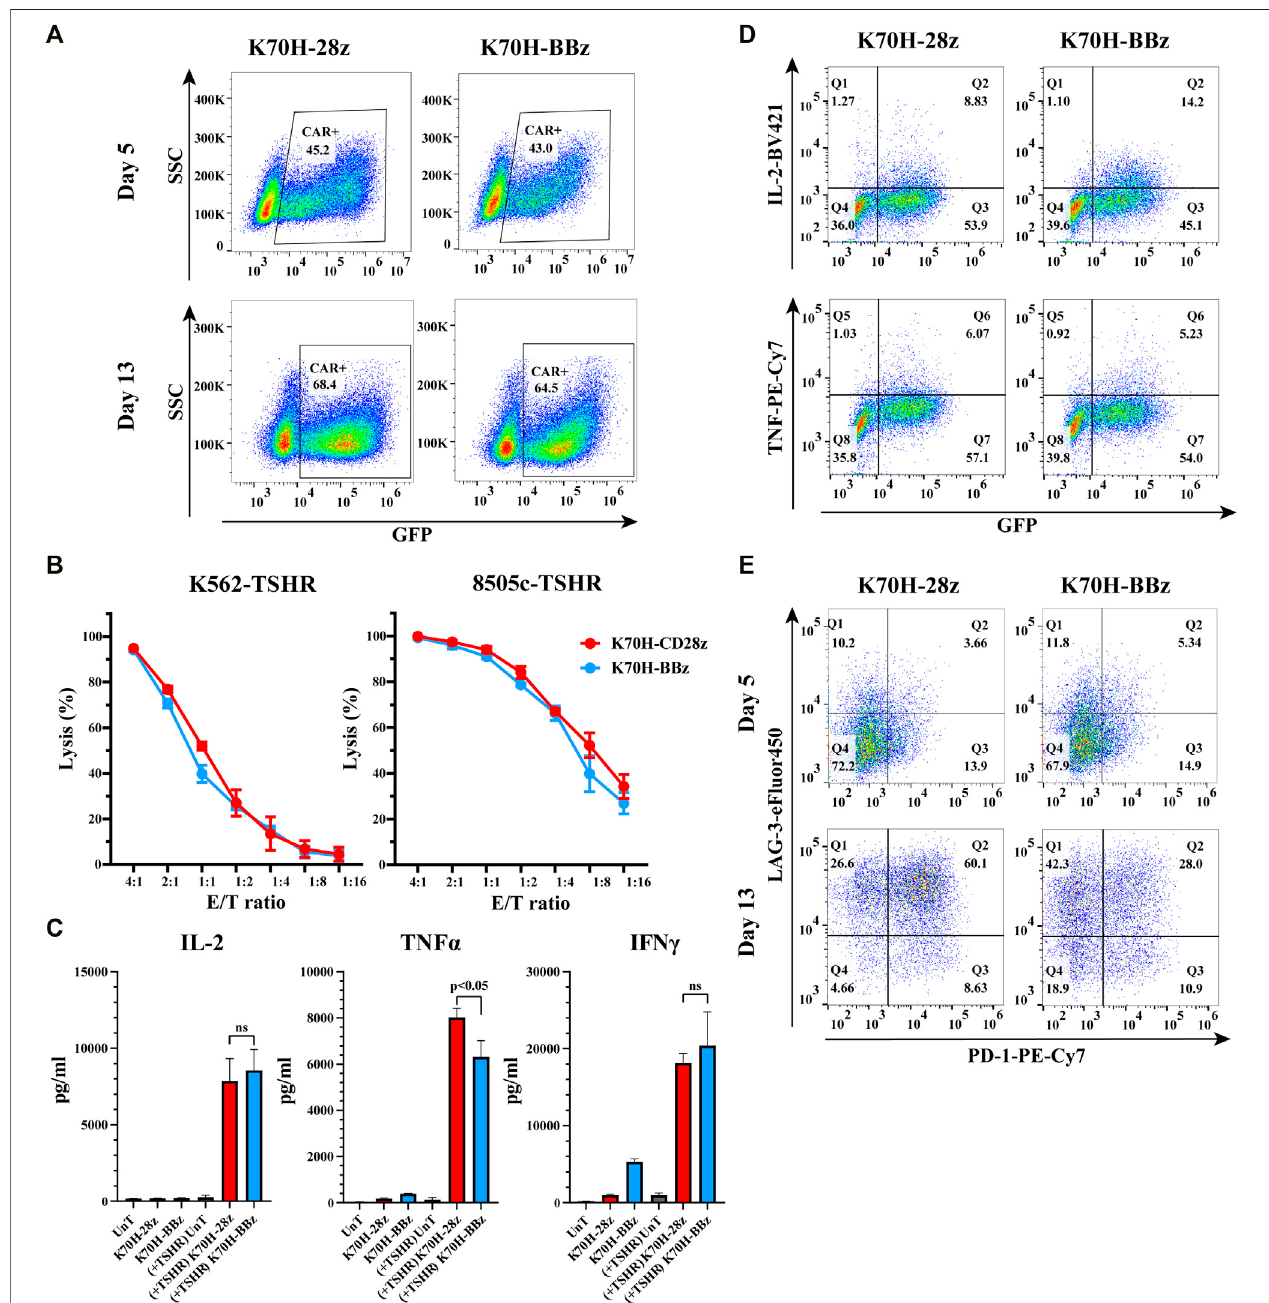
FIGURE2| Invitro characterizationofCD28 and 4-1BB-based TSHR CAR-T cells. (A) CAR expression ofprimary Tcells after retrovirus transduction.Tcells were collectedatday5and13afterPBMCisolationandevaluatedbyFACS.CARexpressionwasindicatedbyGFPintensityofTcells. (B) Invitro killingassayofdifferentCAR- T cells against indicated target cells. (C – E) CAR-T cells were co-cultured with irradiated 8505c-TSHR cells for 24 h. The cytokine secretion of the supernatant (C) , the intracellular cytokines expression (D) and the exhaustion genes expression (E) of CAR-T cells were evaluated by FACS. UnT: Untransduced T cells. Error bars: mean ±